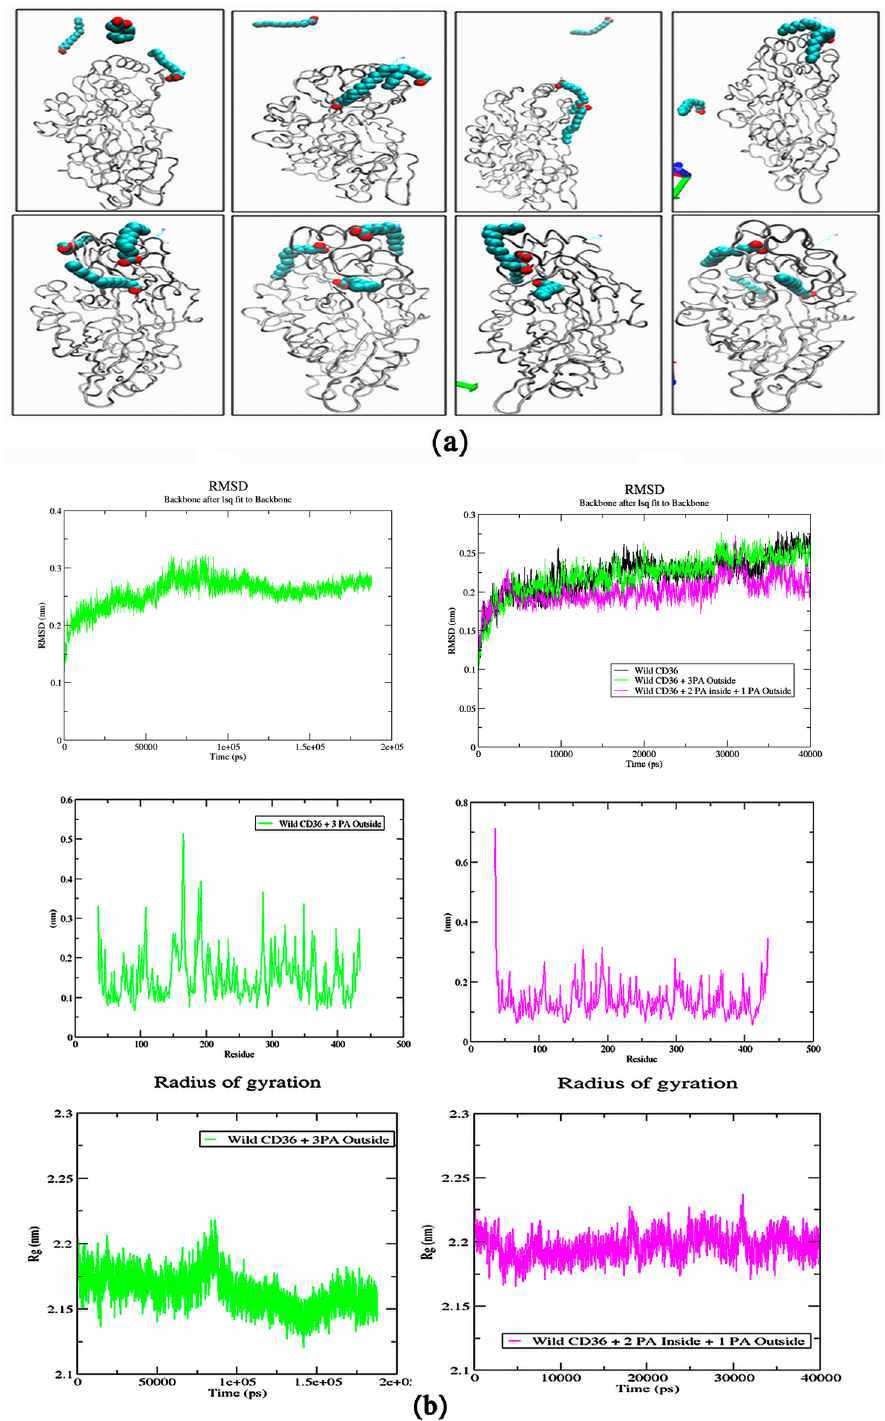
Figure 7. ( a ) Snapshots representing of Fatty acid transport rates, snapshots at 100 ps, 50, 100, 150, and 200 ns taken during each simulation, which depicted the pathway, transport mode and rate of three PLM to the portal CD36 receptor. ( b ) MD analyses of three PLM (three put outside two PLM put inside (green color) and one PLM outside (pink color)) Uptake across the wild type CD36 receptor. RMSD plot, Backbone residual fluctuations (RMSF) plot, time evolution of radius of gyration